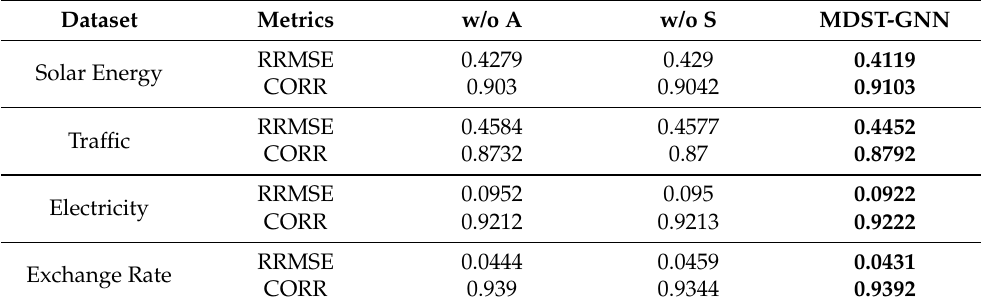
Table 4. Ablation study (Horizon = 24).